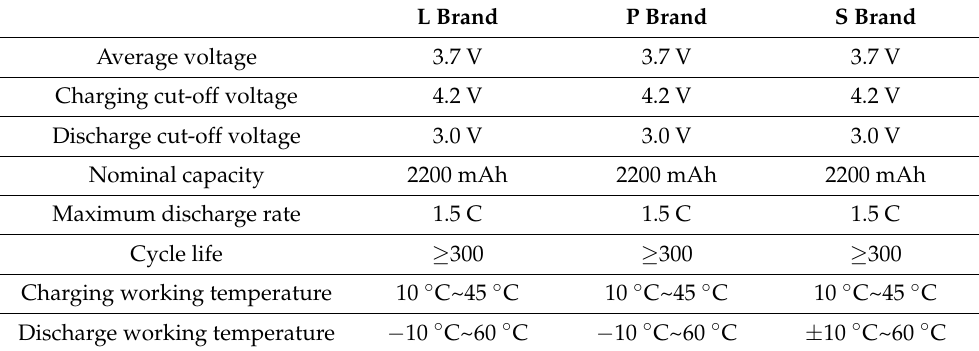
Table 1. Specifications for 18,650 commercial lithium-ion cylindrical batteries. Table 1 . Specifications for 18,650 commercial lithium-ion cylindrical batteries.